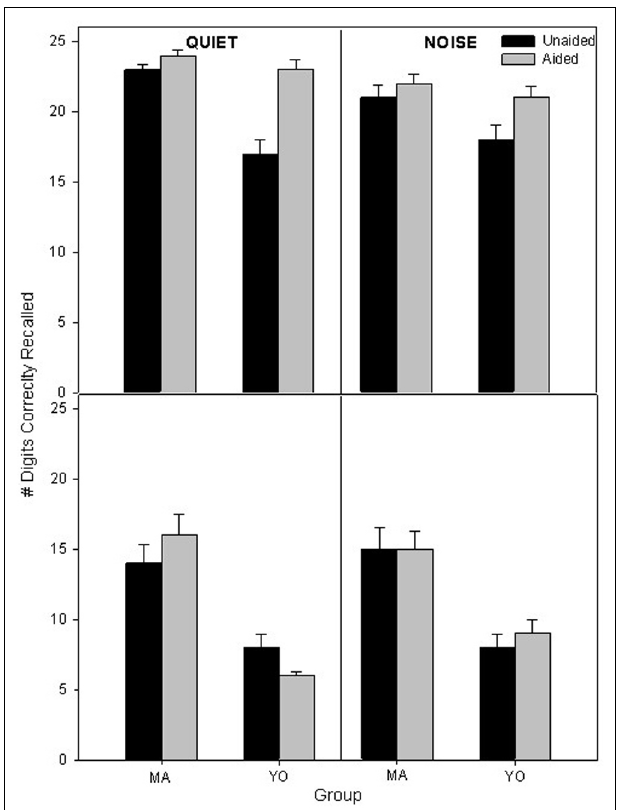
FIGURE 4 | Mean unaided and aided 1-back (top) and 2-back scores (bottom) in quiet and noise for the MA and YO participants. Error bars represent (cid:6) 1 SE.